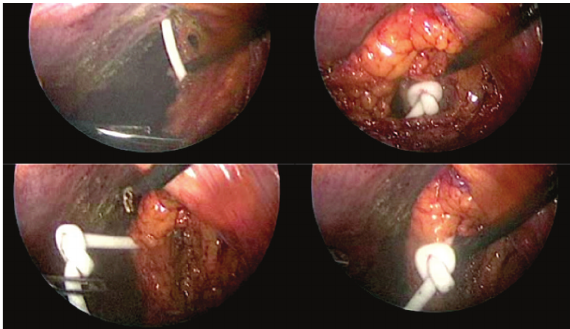
Figure 3: Laparoscopic view depicting the knot formation at the distal peritoneal catheter embedded within